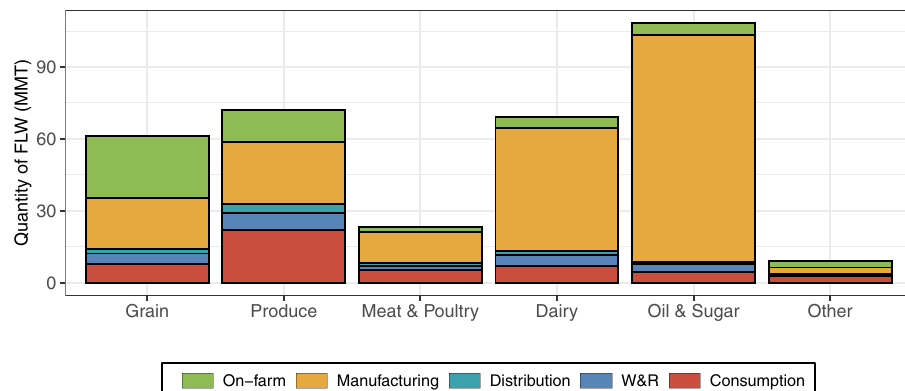
Fig. 4 Contribution to FLW for each commodity group. Breakdown of FLW by FSC stage for each commodity group: grain, produce (fruits and vegetables), meat and poultry, dairy, oil and sugar, other (nuts, seafood, and eggs). The stages remain in the same order in each column: on-farm (green), manufacturing (orange), distribution (teal), wholesale and retail (W&R, dark blue), and consumption (red).